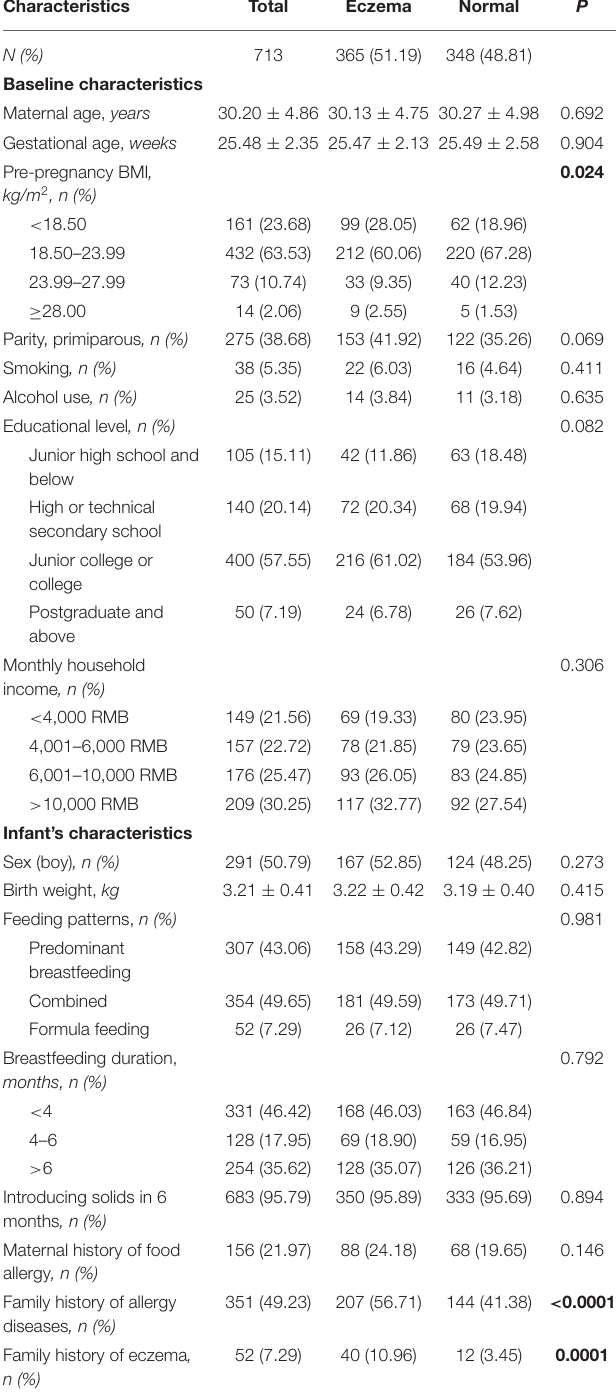
TABLE 1 | Characteristics in a cohort study by categories of eczema a